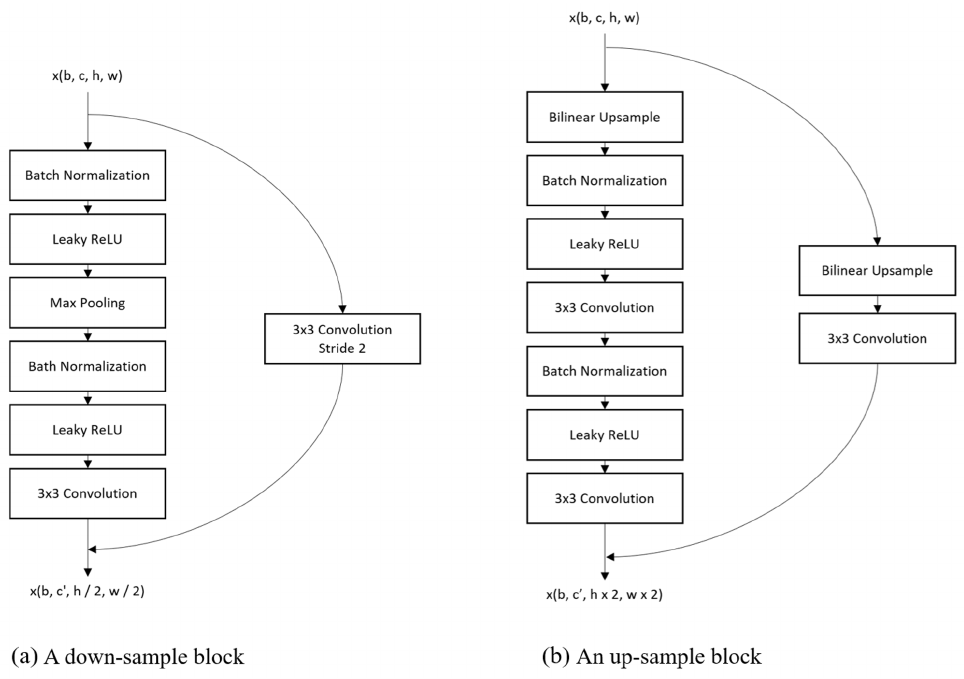
Figure 5. The detailed description of ( a ) an downsampling block and ( b ) a upsampling